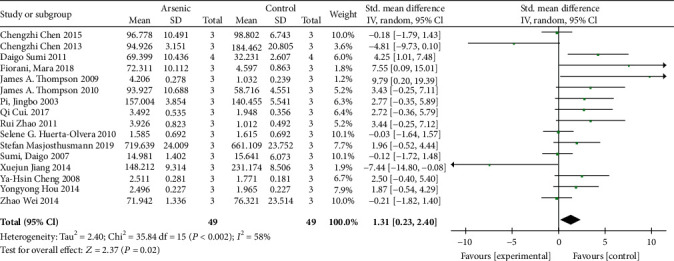
Meta-analysis of the effect of arsenic on the GCLC of r-GCS subunits in vitro. The forest plot shows the effect of arsenic treatment on GSH in the experiment and control group. SMD: standardized mean difference; IV: independent variable; 95% CI: 95% confidence interval; SD: standard deviation. The P value of the overall test effect is 0.02; when P < 0.05, the difference was considered statistically significant.